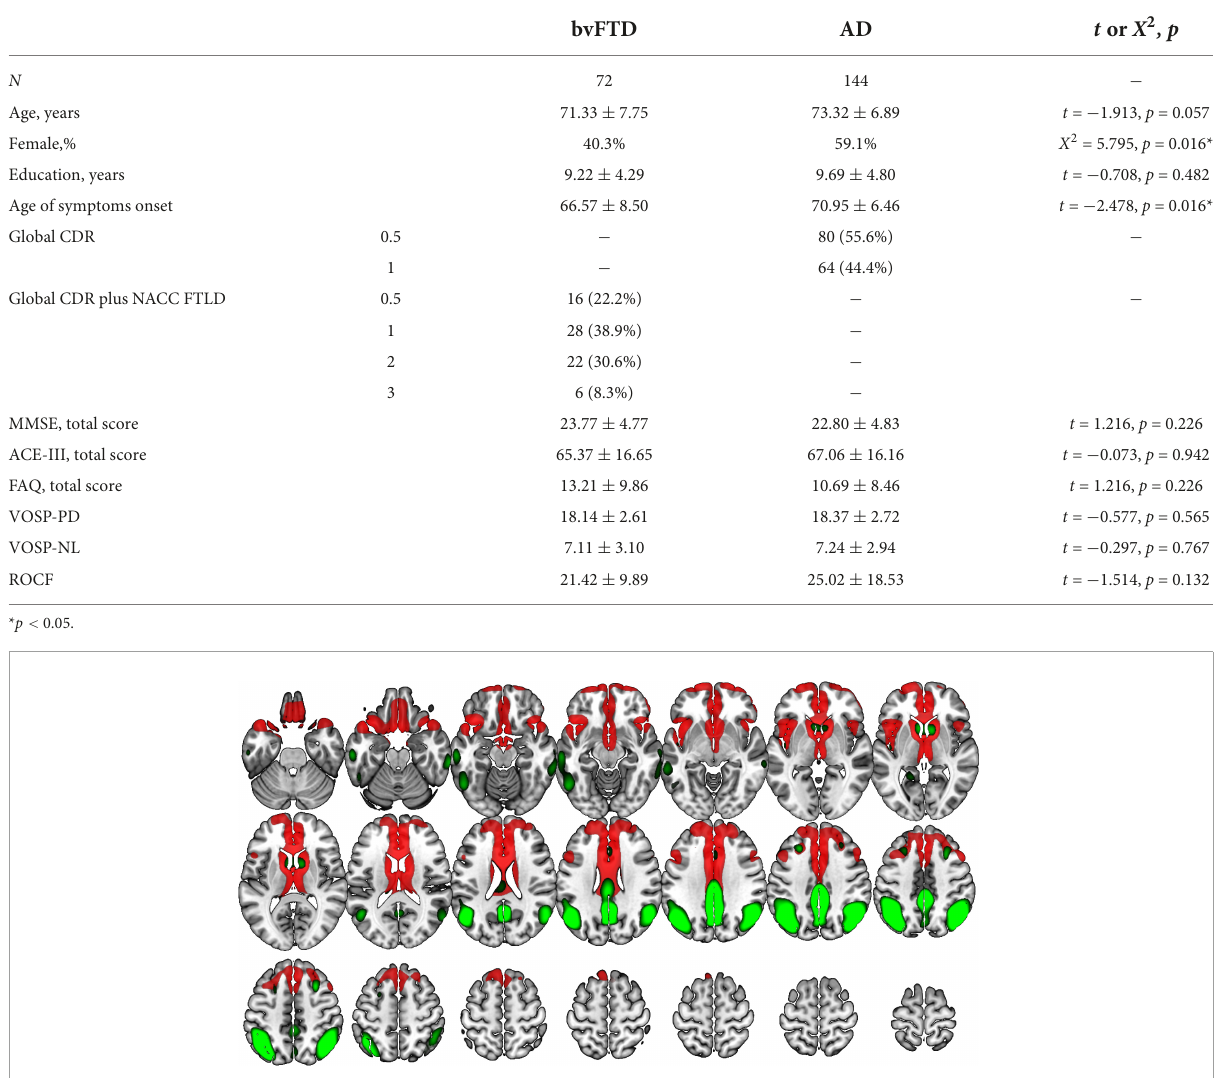
TABLE 1 Demographic, main clinical characteristics, and visuospatial performance.